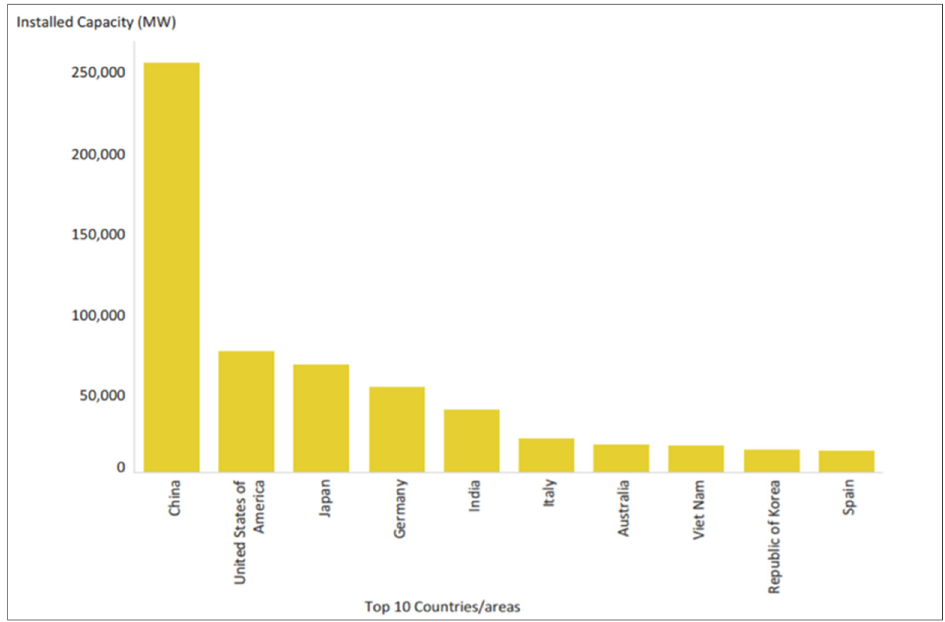
Figure 3. Installed capacity of Photovoltaic Solar Energy in 2020 in selected countries [10].